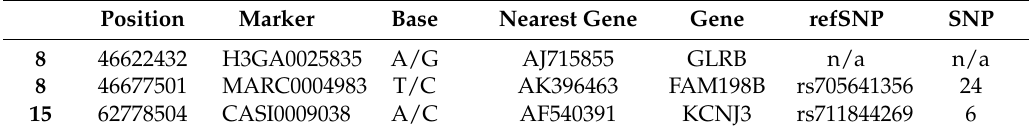
Table 2. Location of significant markers and nearest genes for the Duroc GWAS related to the IMF